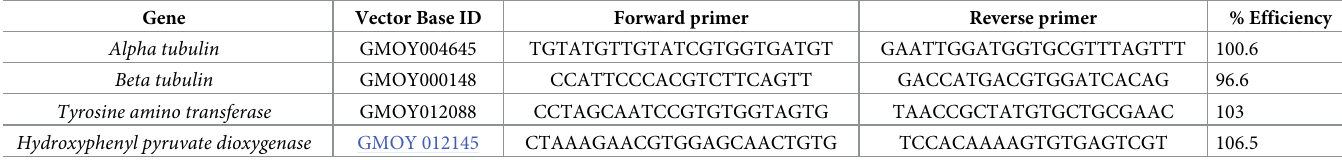
Table 2. Sequence of the primers used to amplify target genes by real-time PCR.